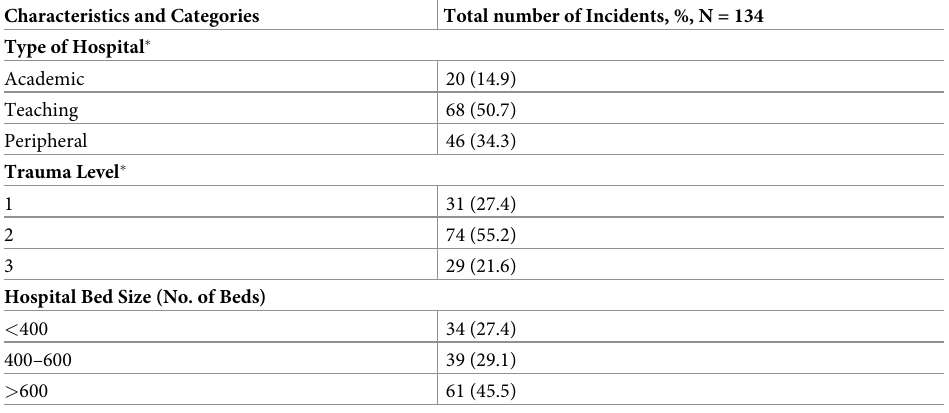
Table 1. Hospital characteristics of internal hospital crises and disasters (IHCDs) occurring in Dutch hospitals from 2000 to 2019. Characteristics and